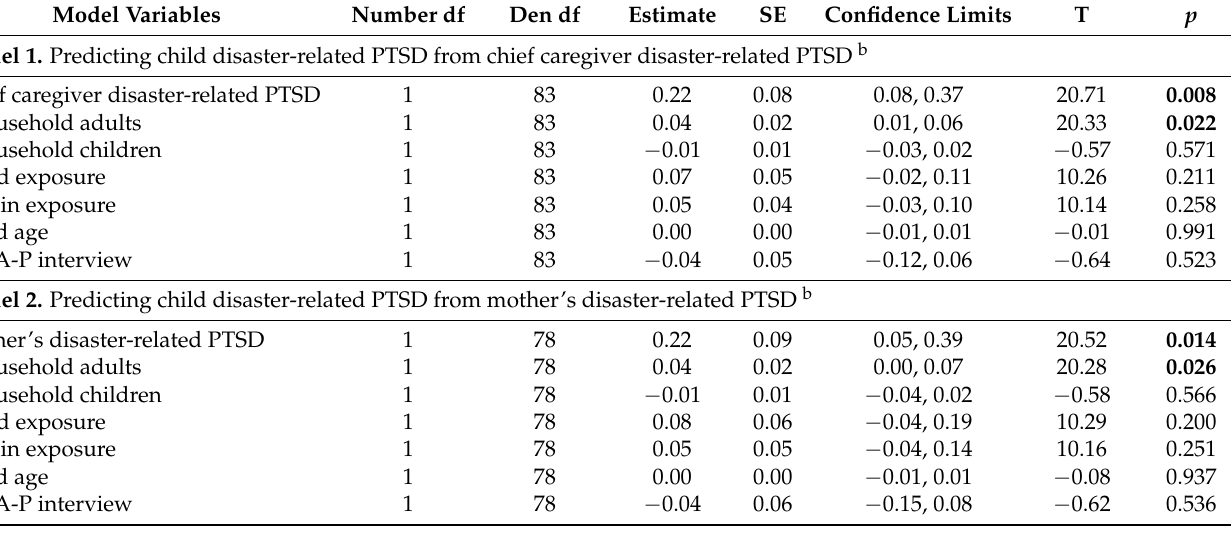
Table 4. Multiple regression models predicting child disorders from adult disorders a